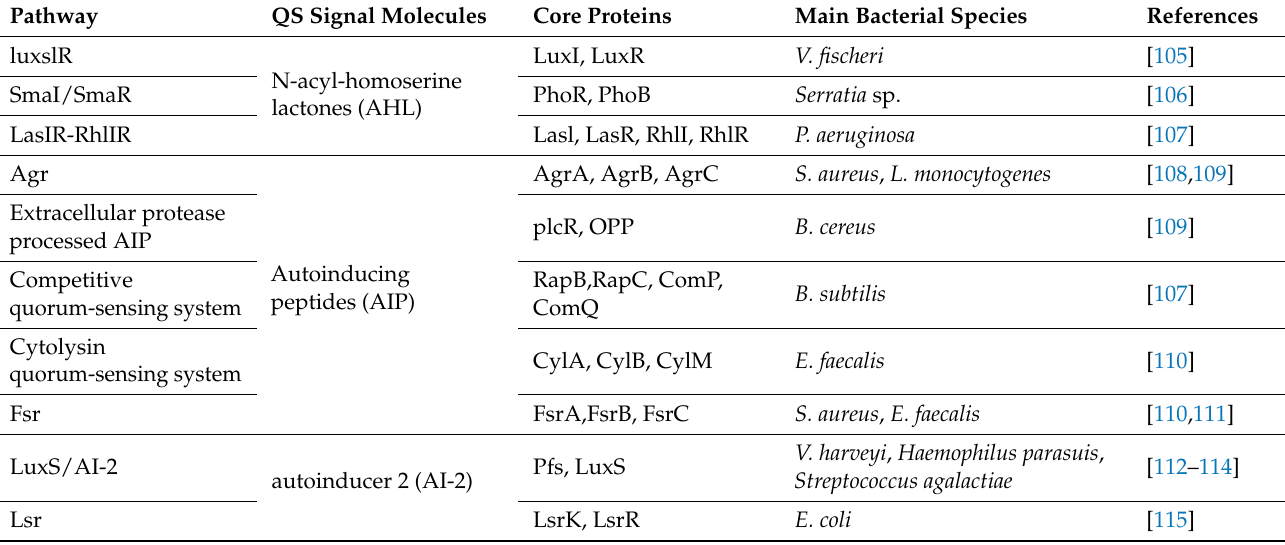
Table 2. Main pathways, signaling molecules and core proteins in QS system associated with the respective bacterial species.